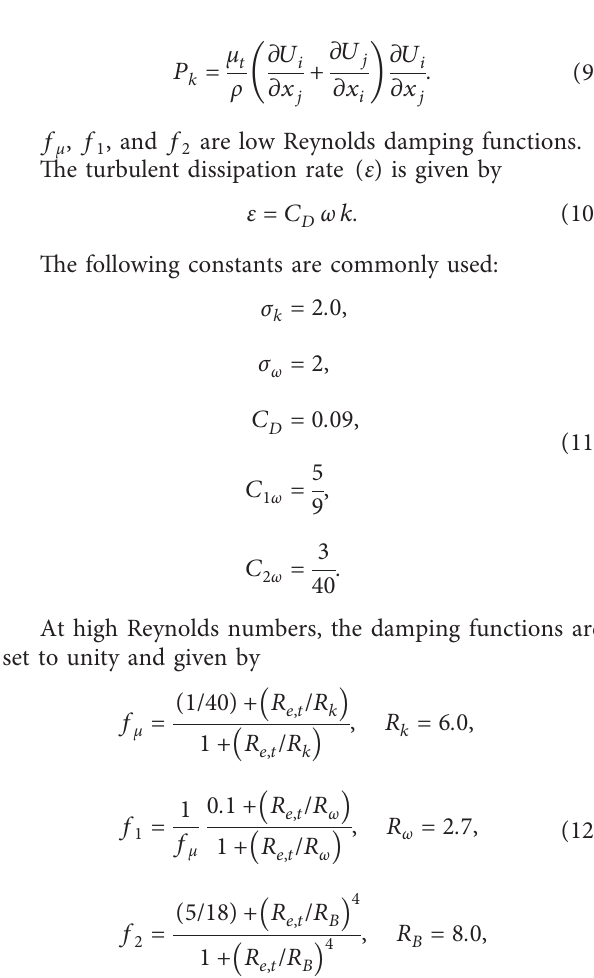
Figure 1: Sketch of 3D geometries of the T-junction (3D-T) and a straight horizontal pipe (3D-S) for a (CAF) flow